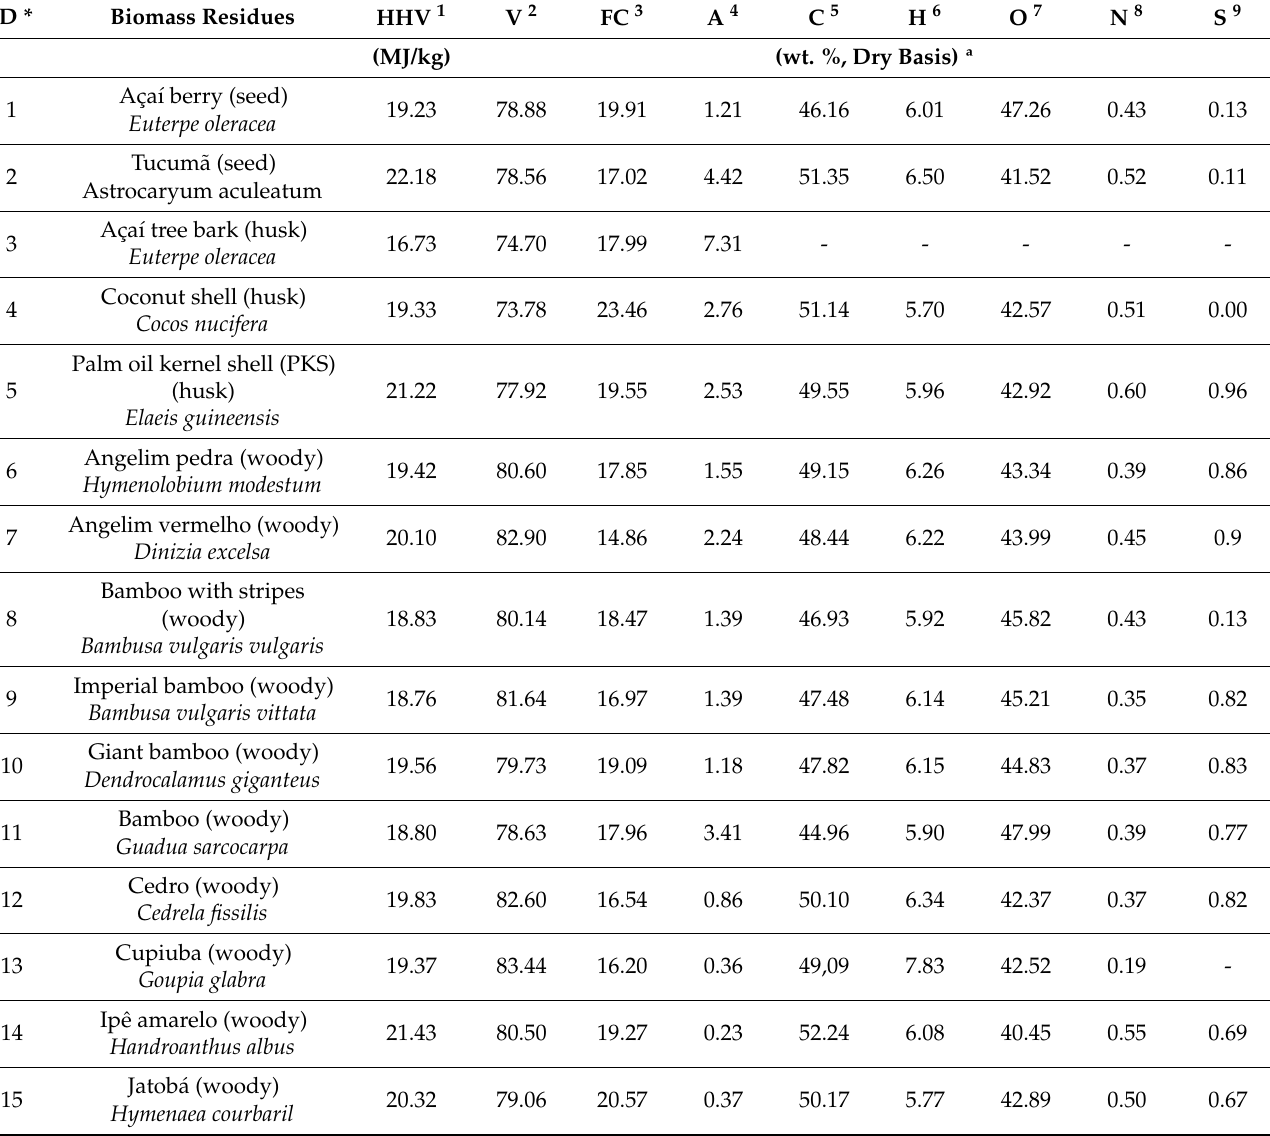
Table 3. Thermochemical data fir proximate and ultimate analyses of the studied biomass